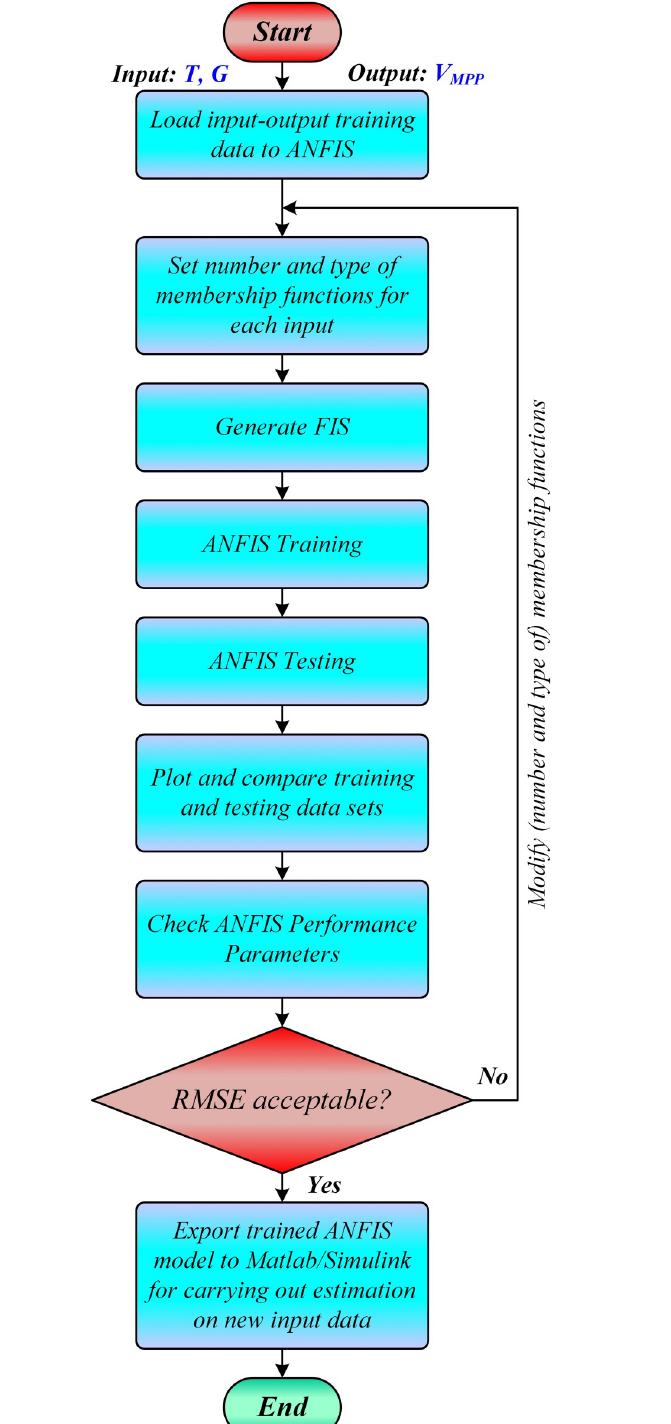
Fig 2. Computational flowchart for ANFIS based V MPP learning.